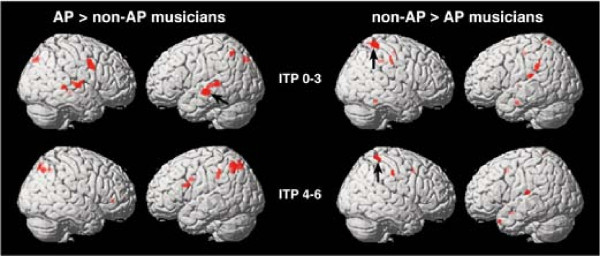
Between-group contrasts. The AP versus non-AP as well as non-AP versus AP contrasts are separated into early (ITP 0–3) and late (ITP 4–6) imaging time points (p < 0.001, uncorrected, voxel extent = 10) superimposed onto the surface reconstruction of a single, normalized brain. Black arrows indicate the cluster of voxels that survived corrections for multiple comparisons (p < 0.05, FDR corrected).